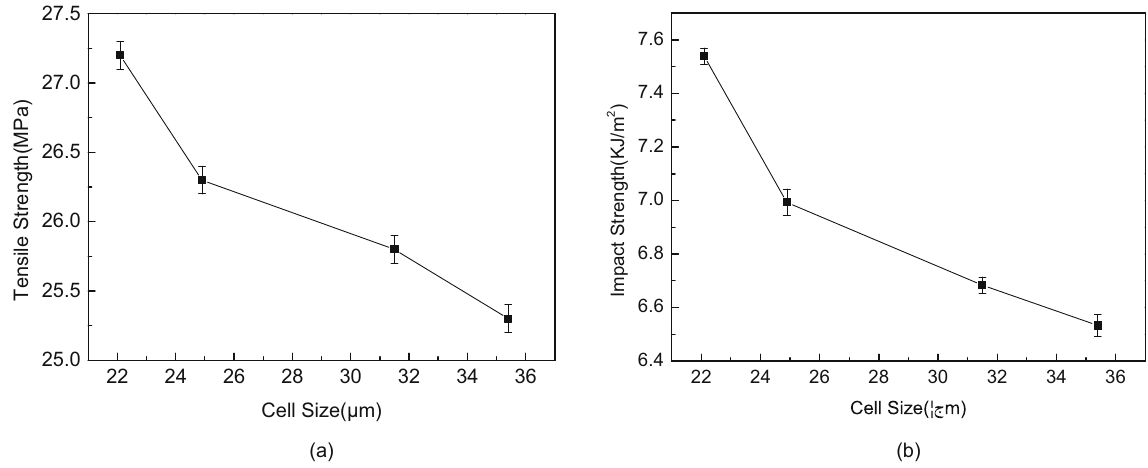
Figure 2: Correlation of mechanical behaviors and cell size for foamed PP/OMMT composites: ( a ) tensile strength and ( b ) impact strength ( 21 ) .